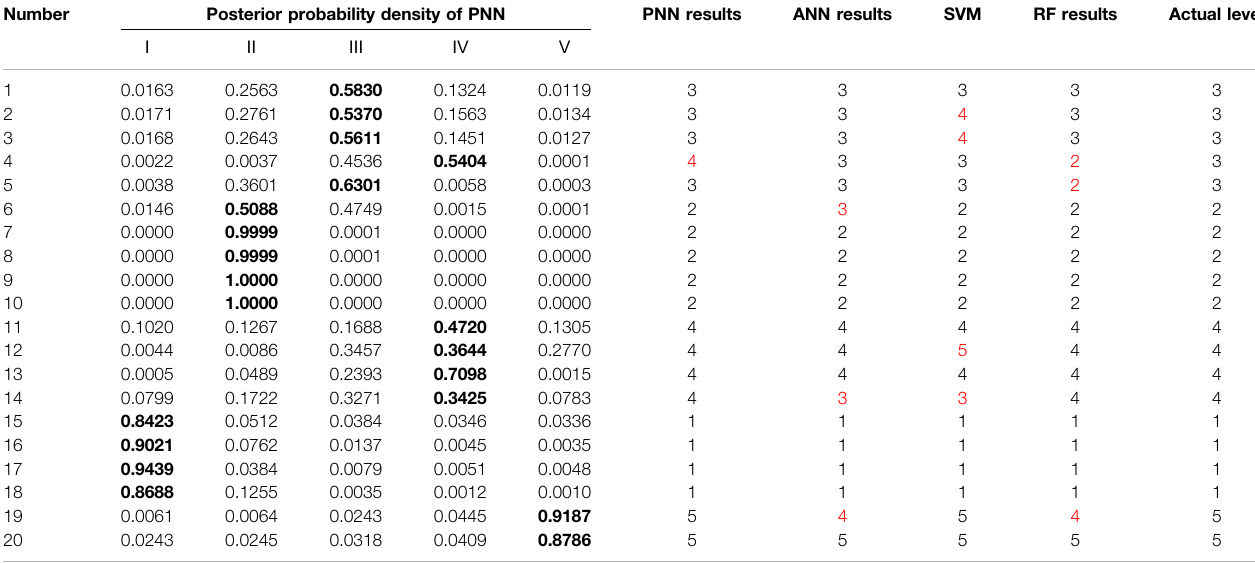
TABLE 8 | Comparison analysis of different prediction models.